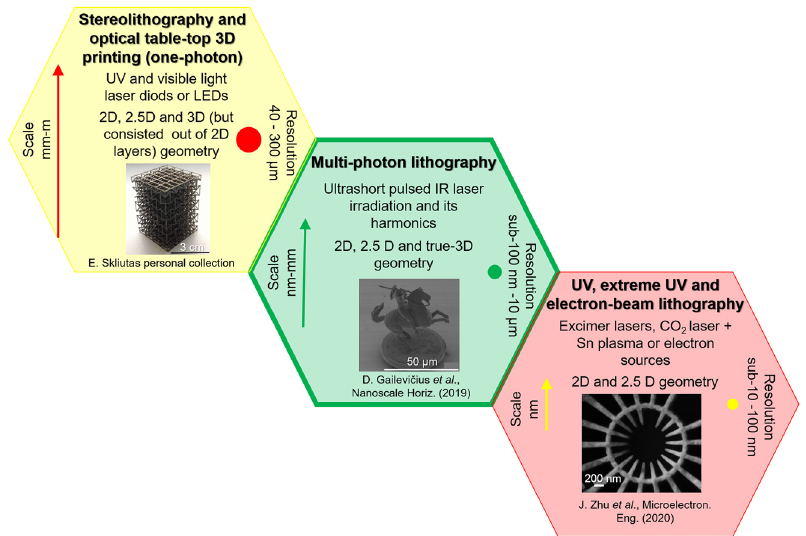
Figure 1: Types of lithography and its capabilities. Pictures reprinted with permission from [20] and